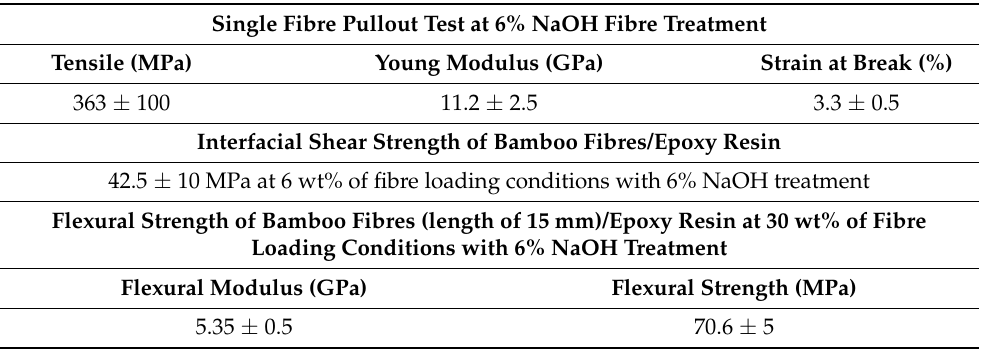
Table 3. Some important information on single fibre pullout test of bamboo fibres, interfacial shear strength and flexural strength of bamboo fibres/epoxy resin [23,24].